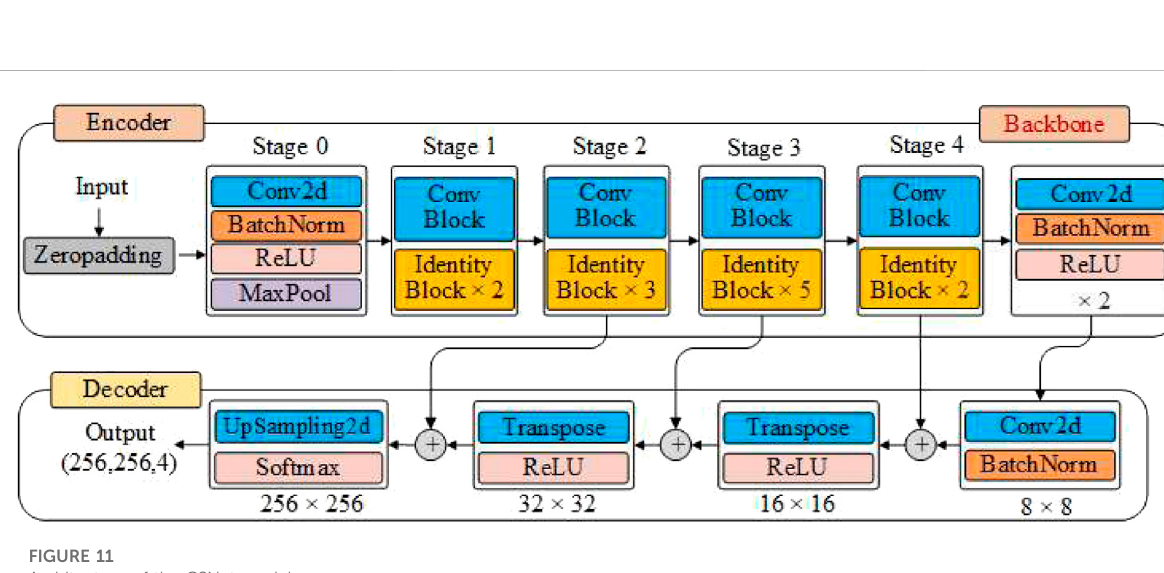
FIGURE 11 Architecture of the CSNet